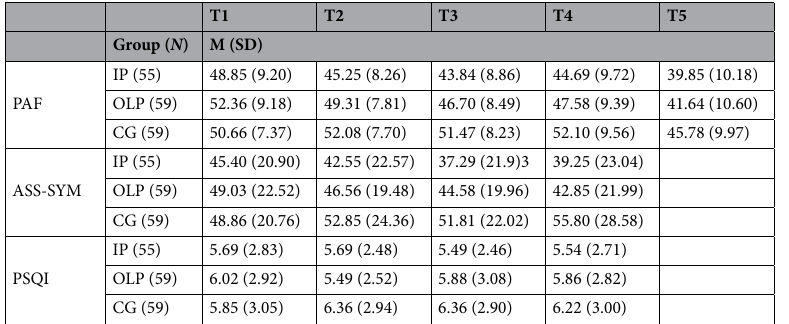
Table 2. Mean values for primary and secondary outcomes per group at all assessed timepoints. ASS-SYM Änderungssensitive Symptomliste (general well-being), CG control group, IP imaginary pill, M mean, OLP open-label placebo, PAF Prüfungsangstfragebogen (test anxiety questionnaire), PSQI pittsburgh sleep quality index, SD standard deviation.